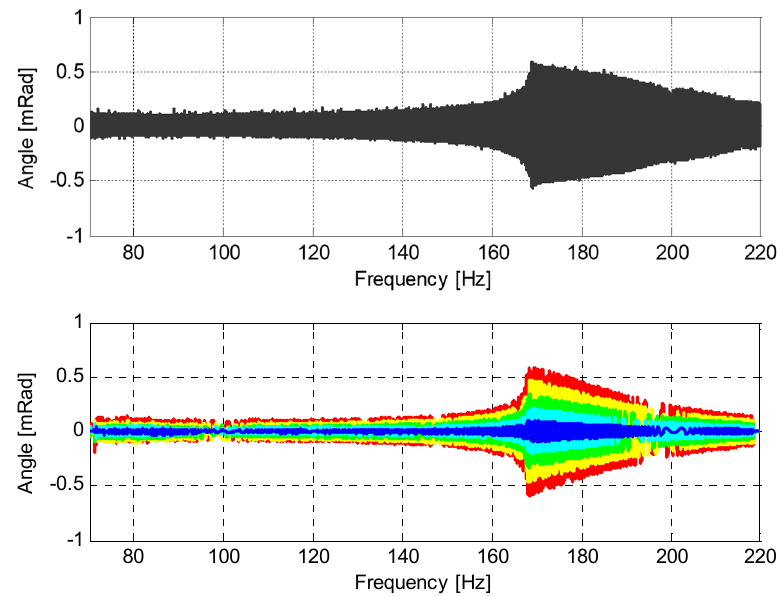
Figure 17. The results of RC testing. Standard RC test results are at the top; the results from the additional accelerometers are at the bottom. Material: Sand 3 (Sa); Isotropic pressure 100 kPa; Frequency spectrum 70–220 Hz; Excitation (torque) amplitude 2 V (– original built-in sensor, – the top sensor, S1, – the second sensor from the top, S2, – the third sensor from the top, S3, – the fourth sensor from the top, S4, – the bottom sensor, S5).